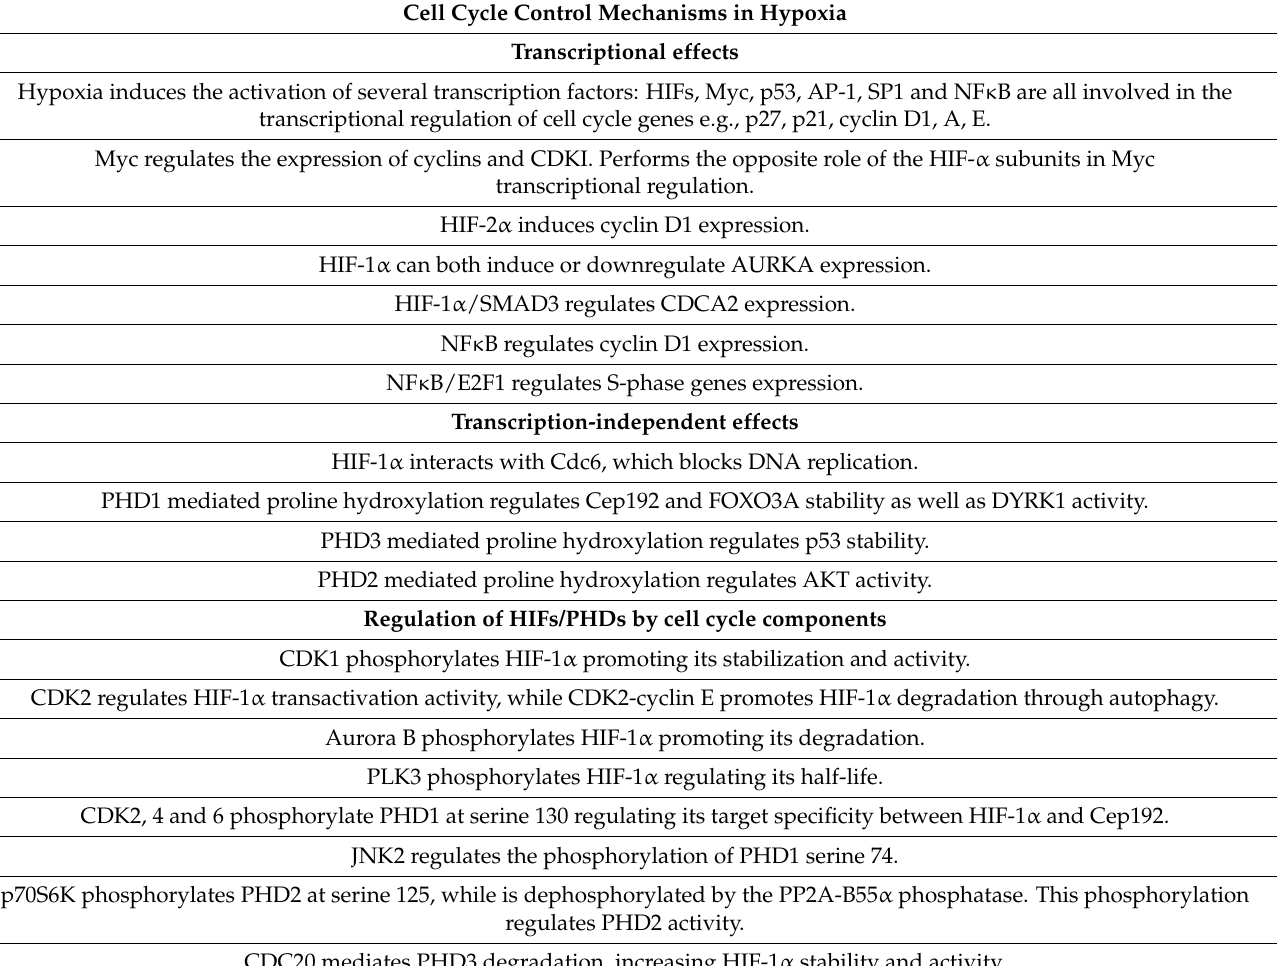
Table 1. Summary of the interaction between hypoxia and the cell cycle. Cell Cycle Control Mechanisms in Hypoxia Transcriptional